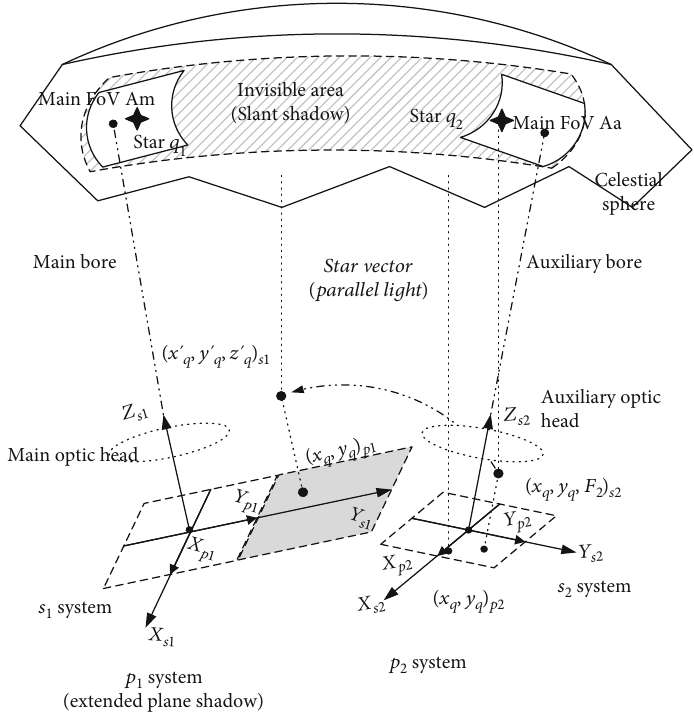
Figure 3: Star imaging diagram for distributed